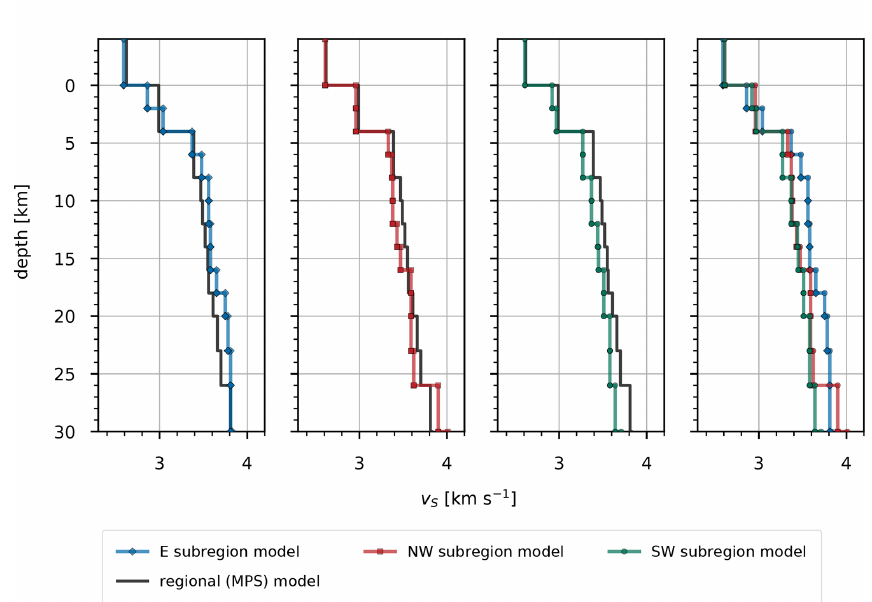
Figure 14. S velocities computed for a particular subregion. The thick black line shows S velocities of the regional (MPS) model. Corre- sponding values are given in Tables S4, S5, and S6.